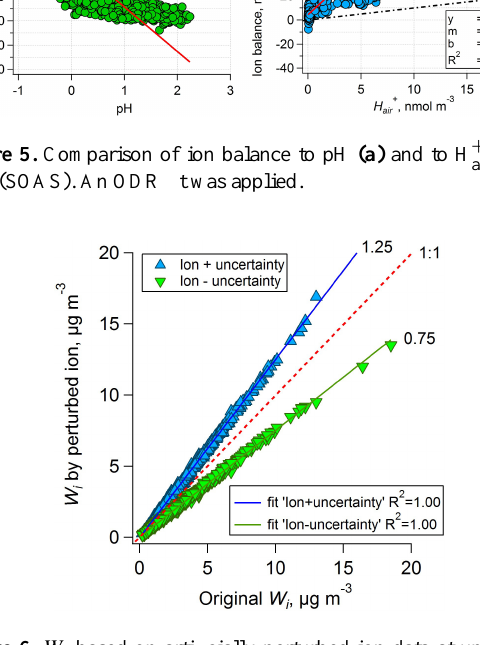
Figure 6. W i based on artificially perturbed ion data at upper and lower uncertainty limits is compared to W i at base level. The slopes indicate the W i uncertainty caused by